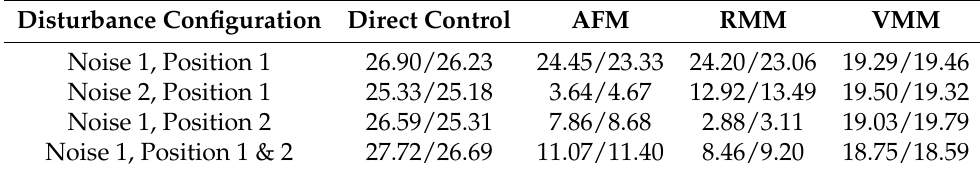
Table 2. Comparison between the reduction (dB) attained by various methods with four disturbance configurations at the left and right ears of the dummy